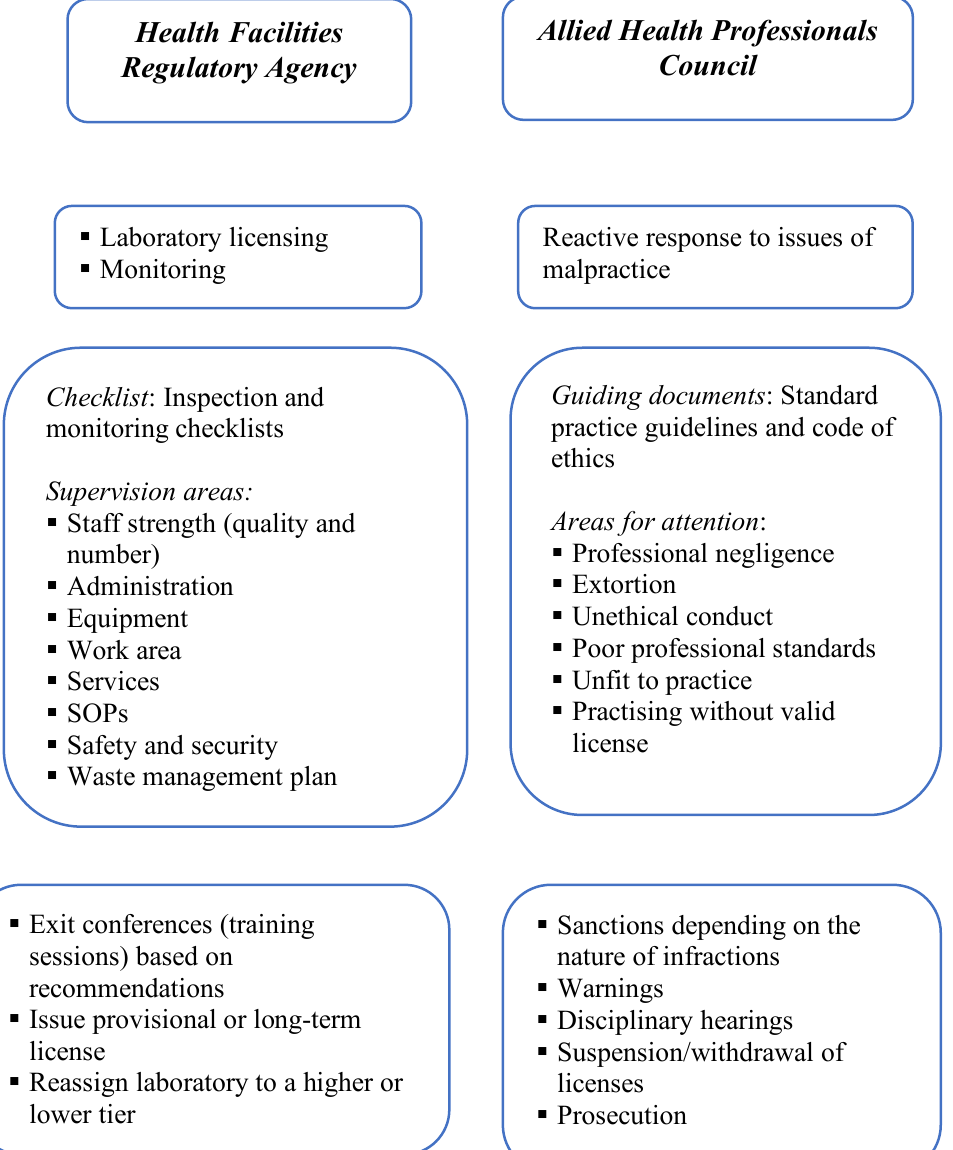
Figure S1: Quality regulation and supervision processes for laboratories and